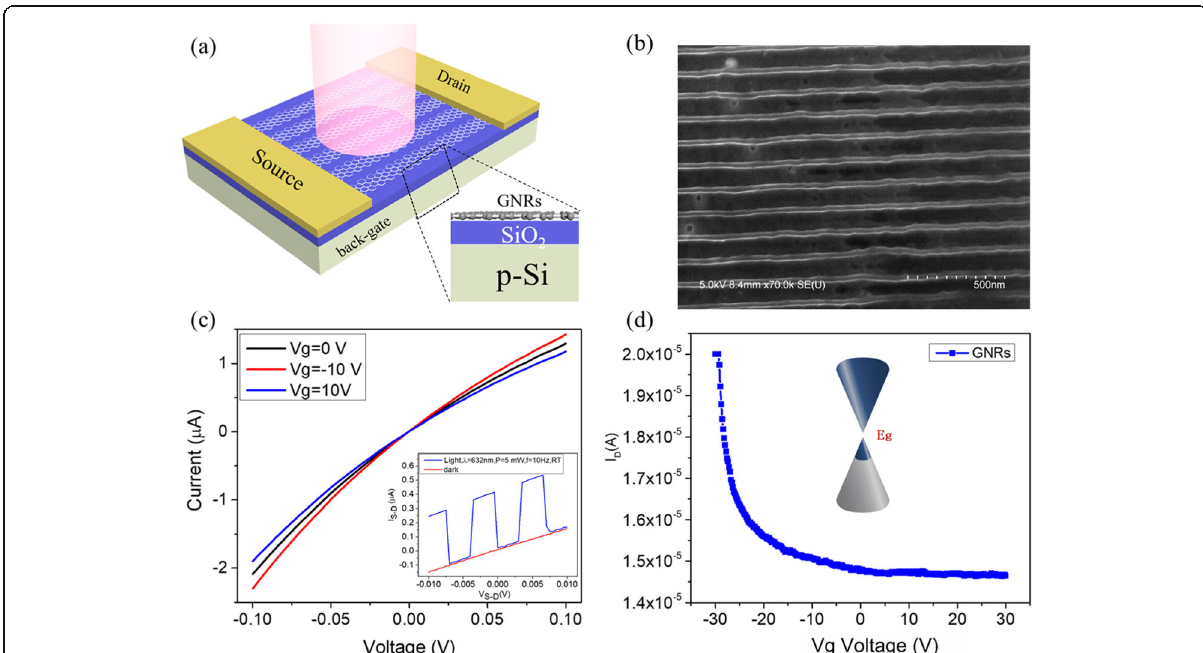
Fig. 1 a A schematic illustration of the GRN photodetector. It is similar to the FET device comprised of the source and the drain electrode on the Si/SiO 2 substrate with a lightly doped Si wafer acting as a back gate. The incident light was modulated by an optical chopper of variable frequency. b SEM image of the GRN photodetector device. c Current-voltage (I-V) characteristics of the GRN device under different back-gate voltage. Inset: I-V characteristics of the device under dark (red line) or illumination with a frequency of 10 Hz (blue line). d The source-drain current versus the back-gate voltage bias of GNR photodetector at room temperature. Inset: schematic diagram of GNR band